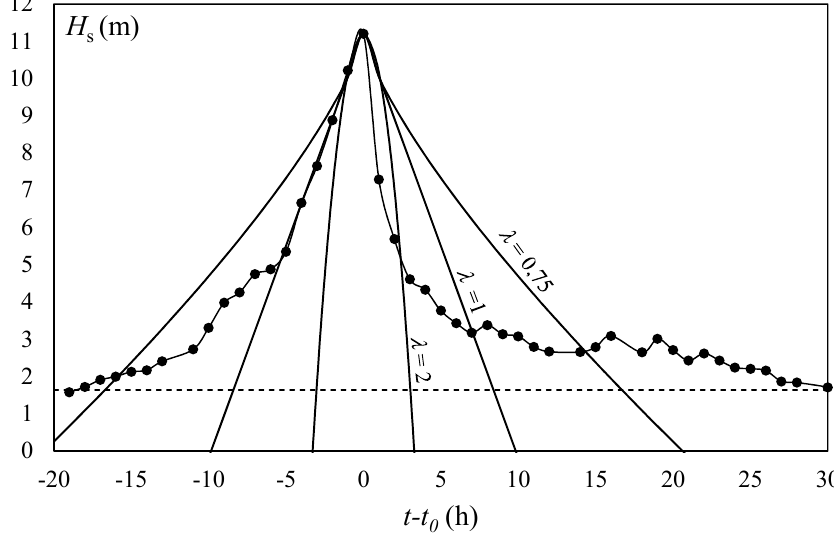
Figure 1. Storm recorded by the 42001 buoy and related equivalent power storms (EPSs) for λ = 0.75, 1,